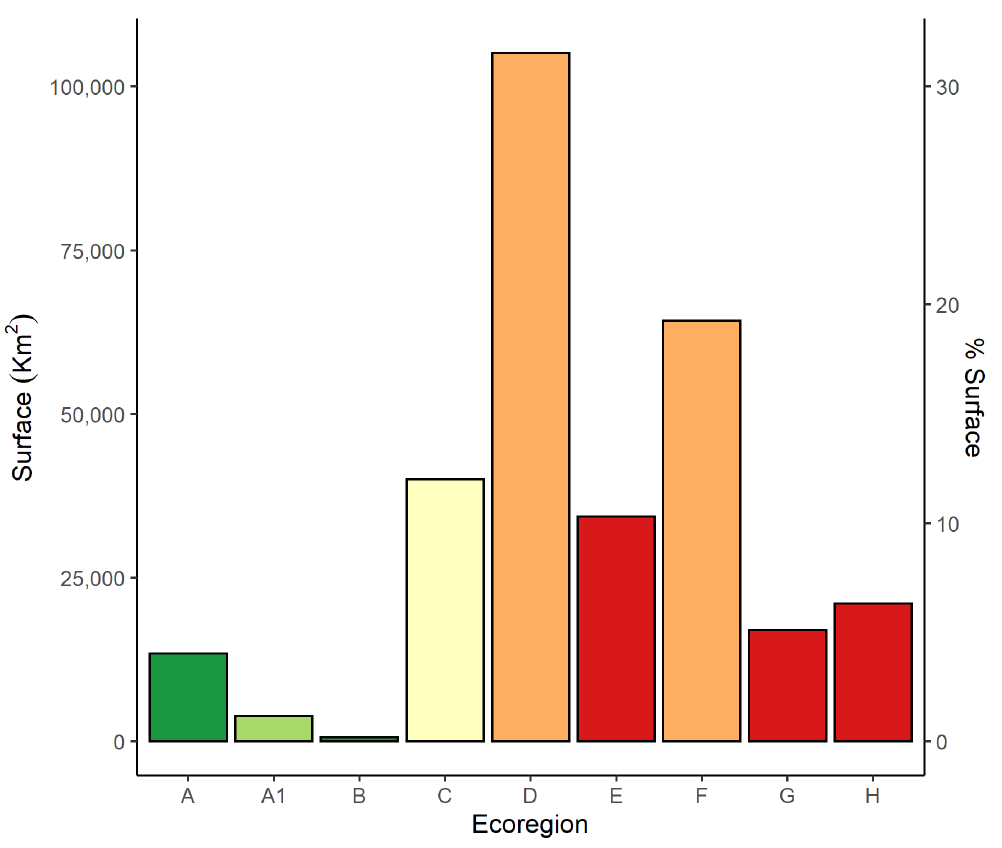
Figure 3. Surface (in km 2 , and in percentage of total surface area), of the 9 ecoregions: Alpine (A), Subalpine (A1), Oromediterranean (B), Montane (C), Dry Submediterranean (D), Padanian (E), Humid Submediterranean (F), Humid Mediterranean (G), Dry Mediterranean (H). Similar colors of the bars depict ecoregions occupying the same altitudinal range. Color codes are green (high-altitude ecoregions), yellow (Montane ecoregion), orange (Submediterranean ecoregions), and red (Mediterranean ecoregions).